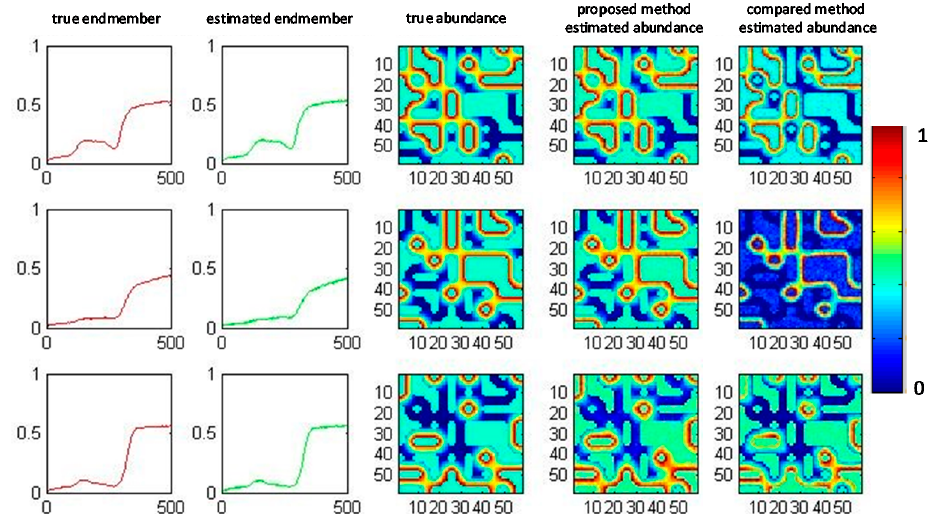
Figure 8. Endmember extraction and abundance fraction results estimated by the proposed method and L 1/2 S-NMF.